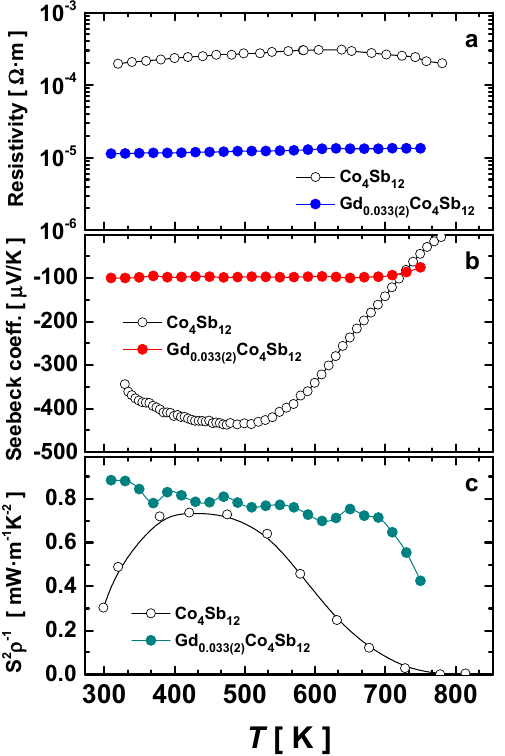
Figure 6. Temperature dependence of the: ( a ) resistivity, ( b ) Seebeck coefficient, and ( c ) power factor (S 2 ρ − 1 ) of the Gd-filled skutterudite obtained under high-pressure conditions at 3.5 GPa. The weighted mobility [49] of the Gd-filled compound, as estimated from the